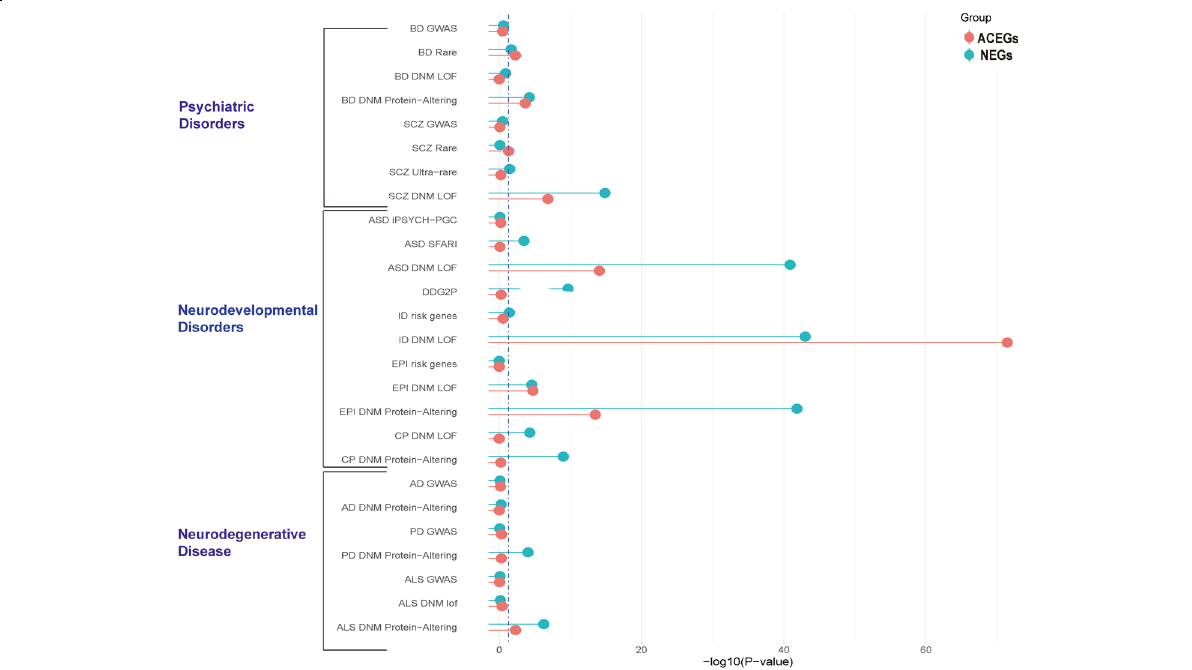
Fig. 4 Enrichment of Neuronal Essential Genes (NEGs) and Achilles Project-speci fi c essential genes (ACEGs) in neuropsychiatric disorders ’ GWAS, rare variants, and de novo mutations. Enrichment was tested for bipolar disorder (BD), schizophrenia (SCZ), autism spectrum disorder (ASD), developmental disorder (DD), intellectual disability (ID), epilepsy (EPI), cerebral palsy (CP), Alzheimer ’ s disease (AD), Parkinson ’ s disease (PD), and amyotrophic lateral sclerosis